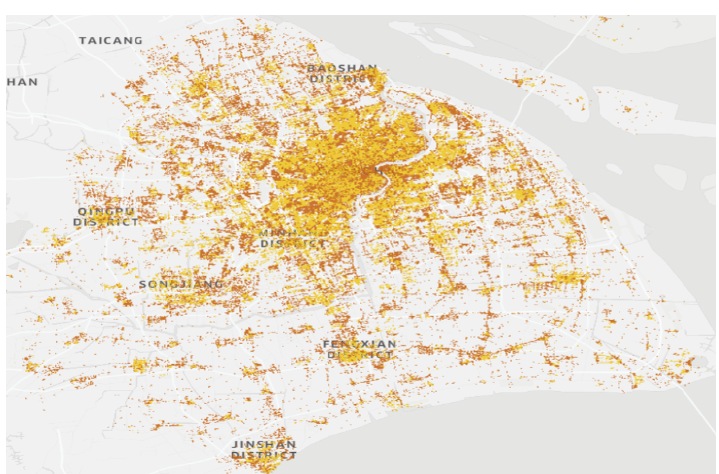
Figure 5. The POI number dataset of Shanghai.